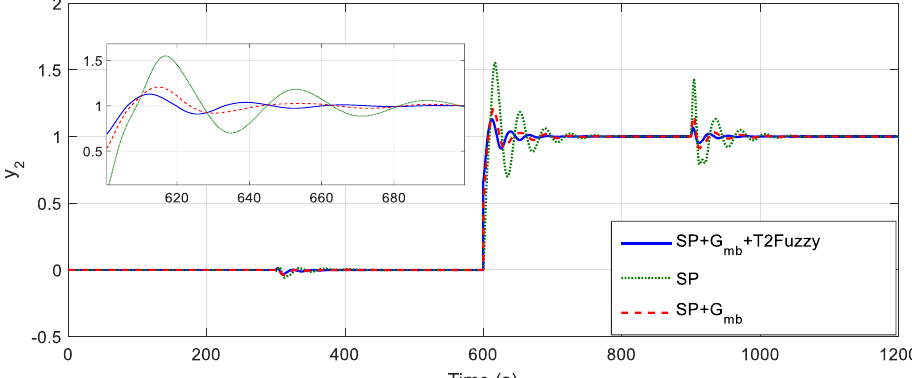
Figure 20. Performance of three control methods for 𝑦 2 for example 2.